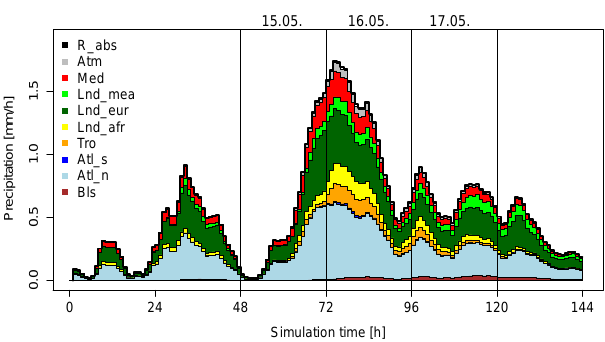
Figure 5. Time series of hourly precipitation (in mm) from individ- ual moisture sources (shading) in the target region in eastern Europe (see Fig.